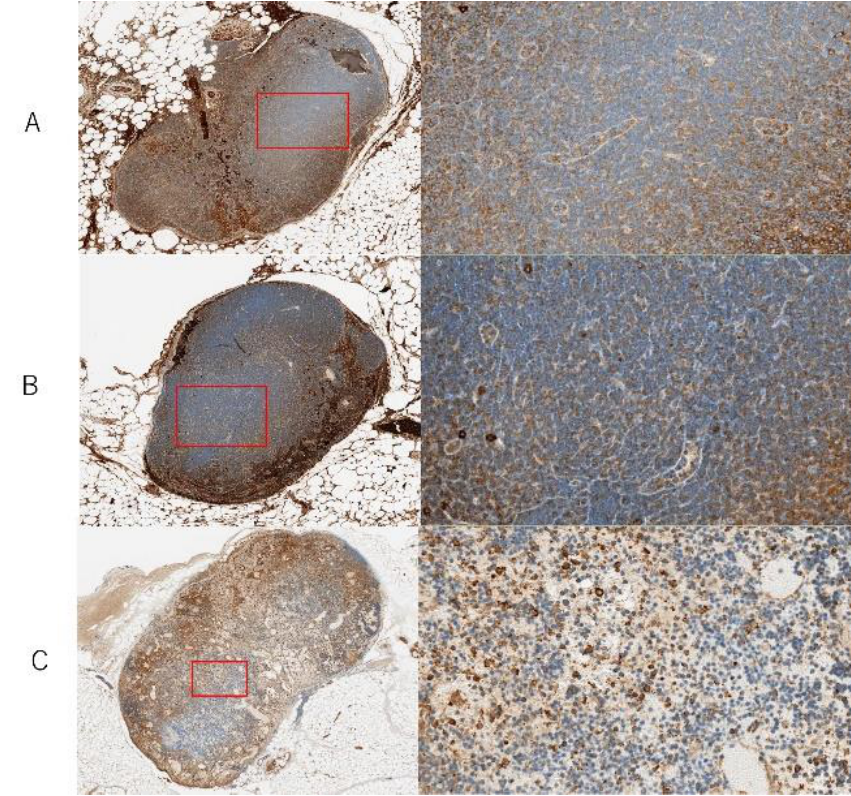
Figure 8. Myosin light chain 9, 12a, and 12b (Myl9/12) immunostaining of follicles at 72 h after surgery. The left image shows the entire LN and a magnified image of the red square area on the right (×400). ( A ) In control LNs, very few Myl9/12-positive immunocompetent cells were observed. ( B ) In ischemic LNs, small numbers of Myl9/12-positive immunocompetent cells were observed. ( C ) In congestive LNs, numerous Myl9/12-positive immunocompetent cells were observed.